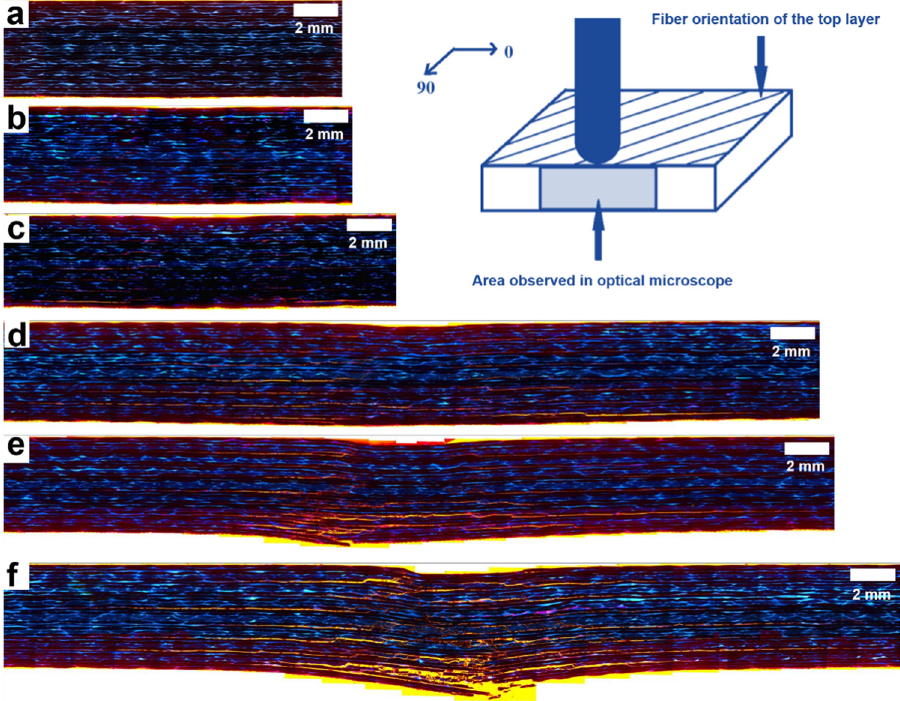
Figure 4: The corresponding optical micrographs for points a – f in Figure 2, respectively. Inset: cross - section for microscopic